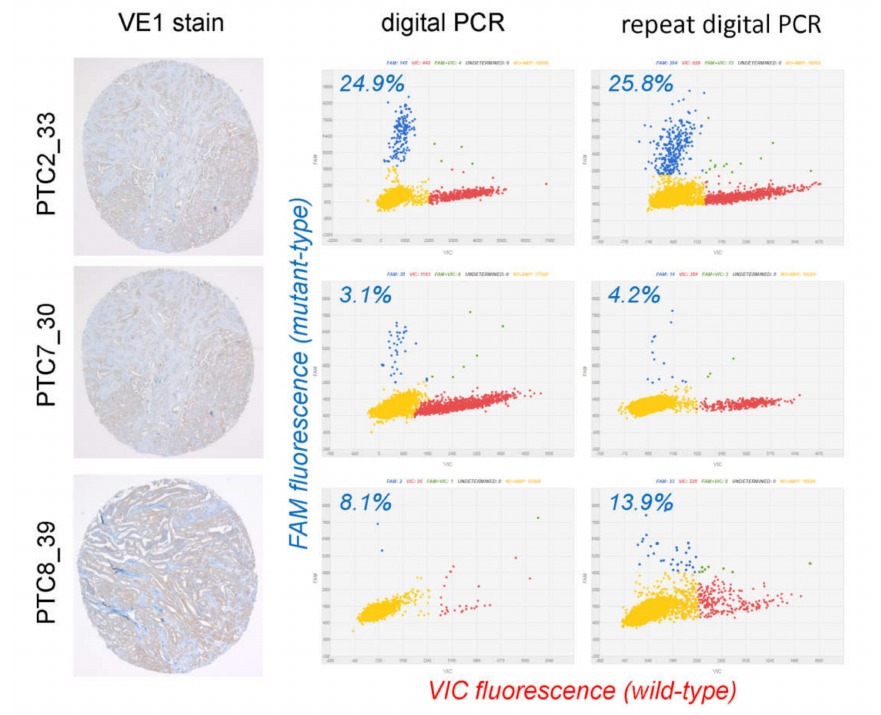
Figure 5. Droplet digital PCR analysis in discordant cases showing VE1 expression but wild type of BRAF using Sanger sequencing (false negative Sanger sequencing). All three cases turned out to be mutant type using digital PCR. Blue, red, green, and yellow dots represent the BRAF V600E mutant allele, wild-type allele, both alleles, and none (no template), respectively. Variant allele frequency is shown as percentage. FAM, 6-carboxyfluorescein; VIC,